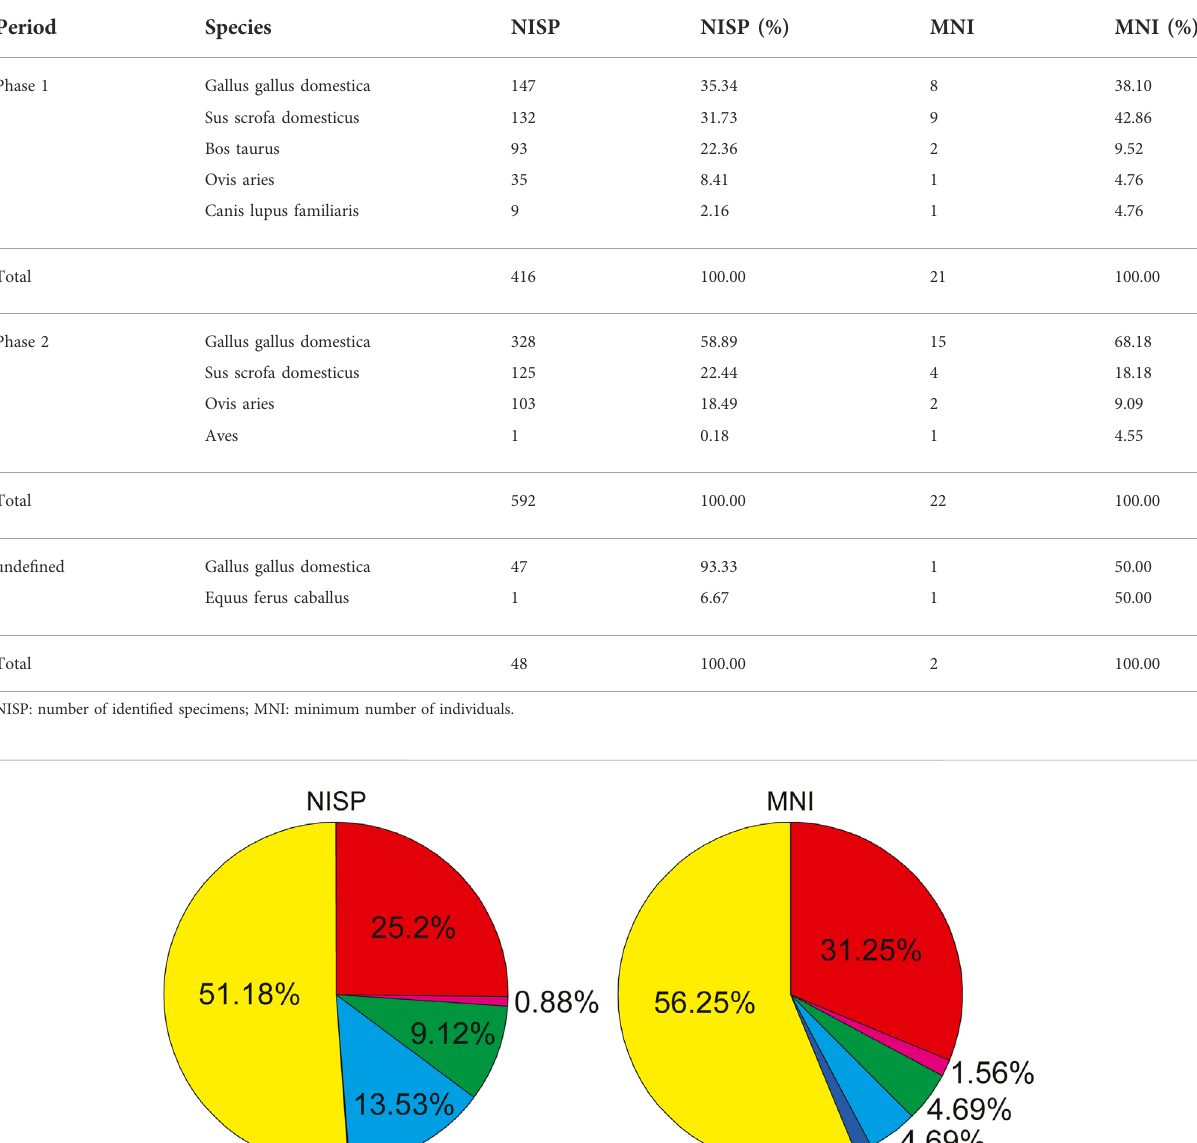
FIGURE 2 Assemblages of domesticated animals from the HSG Cemetery. (NISP: the number of identi fi ed specimens, MNI: the minimum number of individuals)